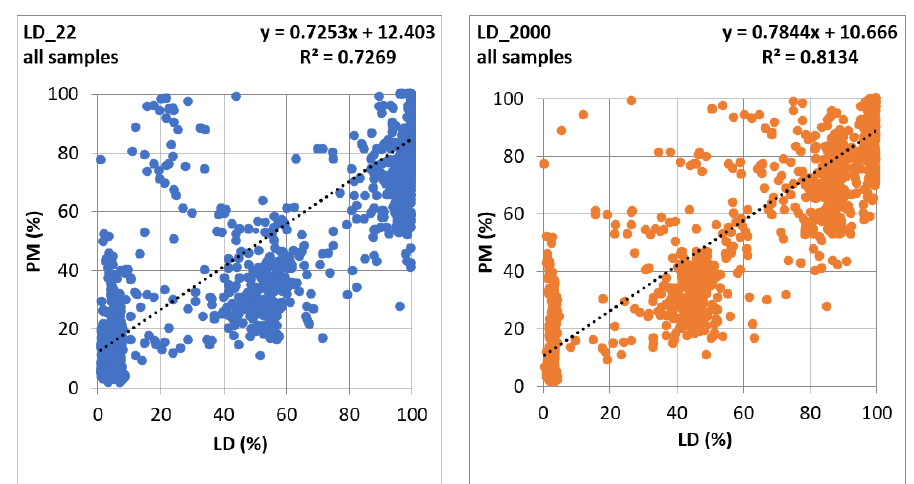
Figure 3. Linear regression correlation between pipette method (PM) and laser diffraction method for all soil samples as determined by Analysette22 MicroTec plus (LD_22) and Mastersizer2000